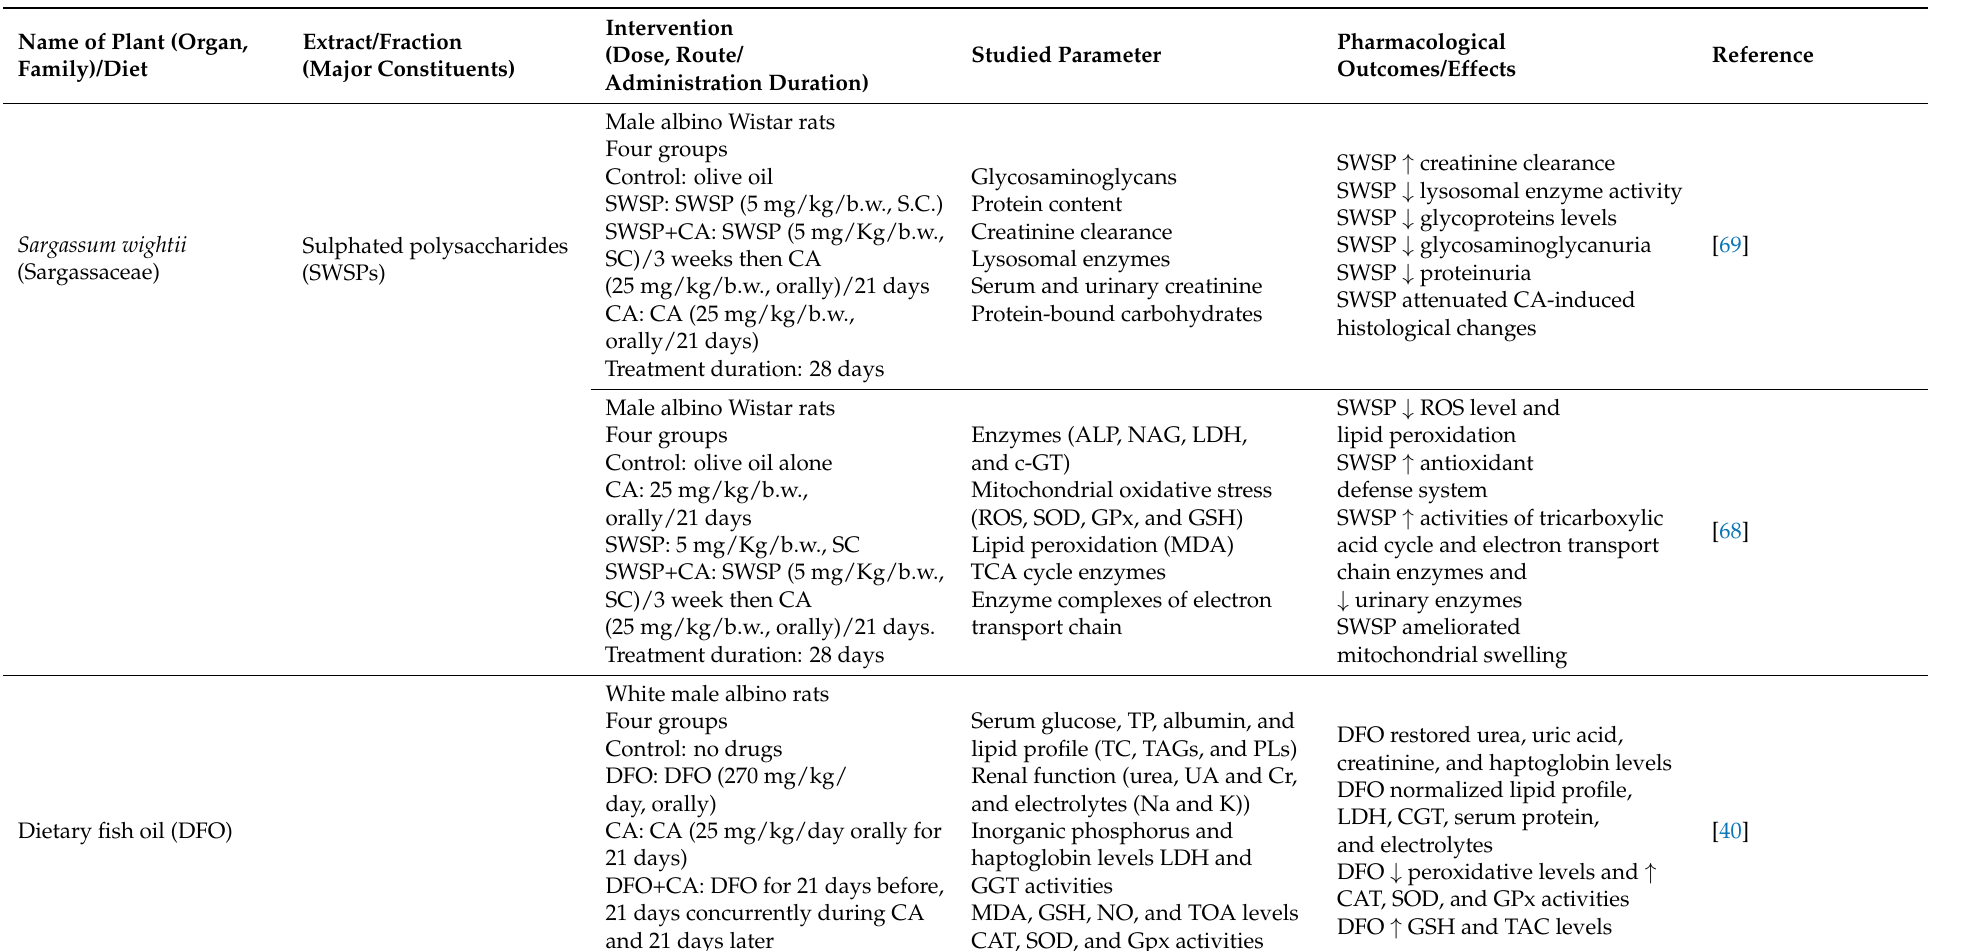
Table 3. Plants extracts and/or faction effects on CA-induced renal